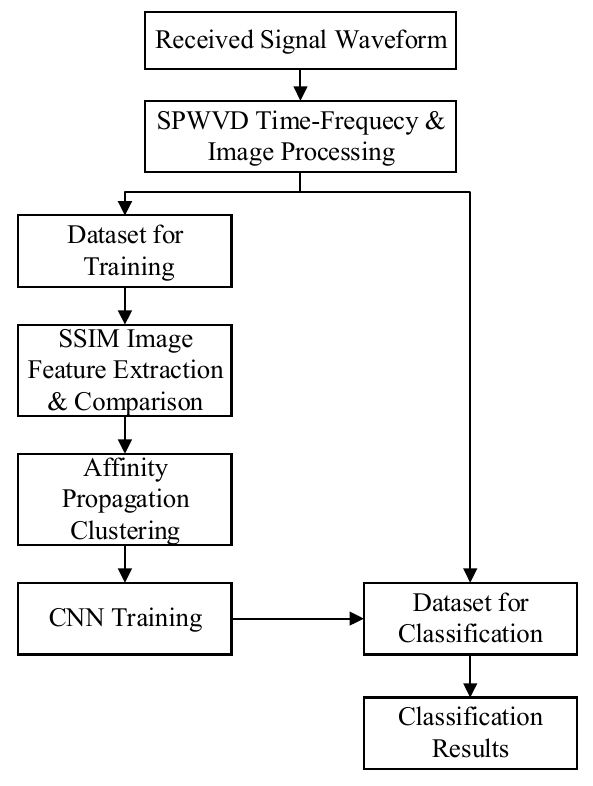
Figure 1. The architecture of the Proposed Method.